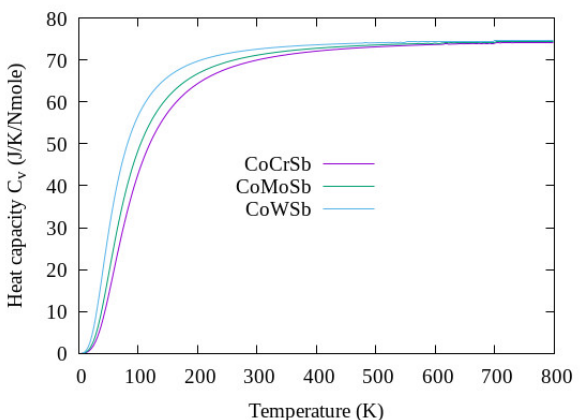
Figure 6. Heat capacity C v against temperature for Type-I CoYSb alloy.